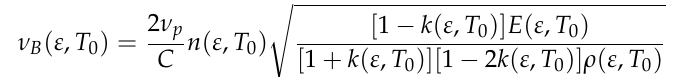
Figure 5. Principle of strain monitoring with BOTDA technology.